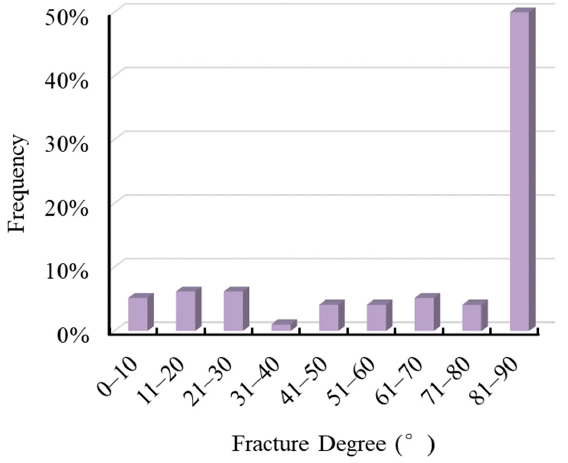
Figure 4. Histogram of core fracture angle.